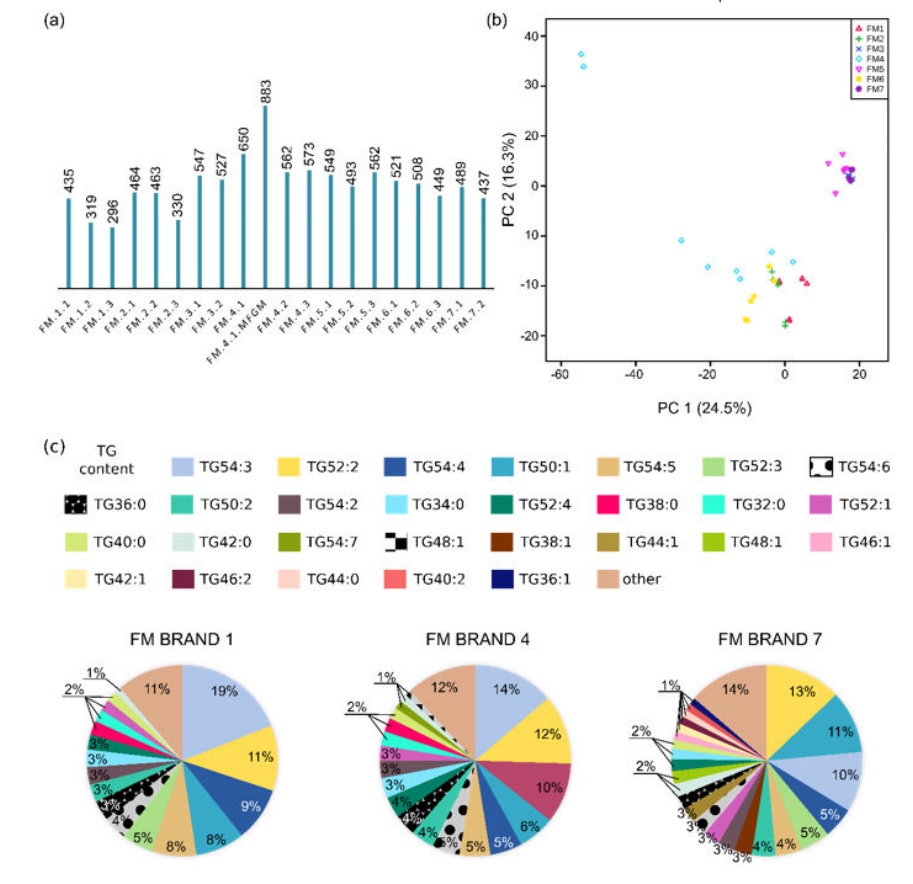
Figure 3. ( a ) Average number of MFs detected in the studied FM samples. FM1.1 stands for formula milk of brand one with an age range target of 0–6 months; FM1.2 stands for formula milk of brand one with an age range target of 6–12 months; FM1.3 stands for formula milk of brand one with an age range target < 12 months. ( b ) The score plot of the lipid fingerprints of FM samples: brand one (red triangles), brand two (green plus sign), brand three (dark blue cross), brand four (light blue rhombi), brand five (reversed pink triangles), brand six (yellow rectangles), brand seven (purple star). ( c ) Average percentage relative amount of lipid species in all FM samples of brands one, four and seven. MF, molecular feature; TG,